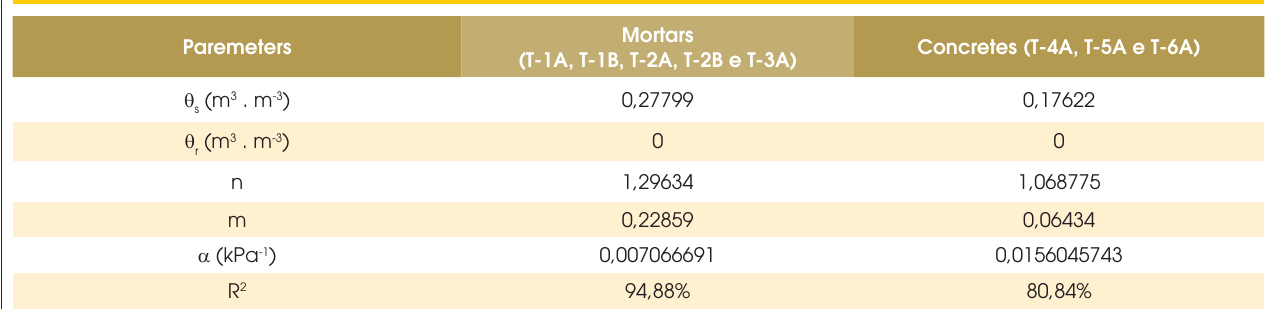
Table 6 – Fitting parameters ofthe water retention curves, according to the Van Genutchen [1] model, for mortars and concrete samples